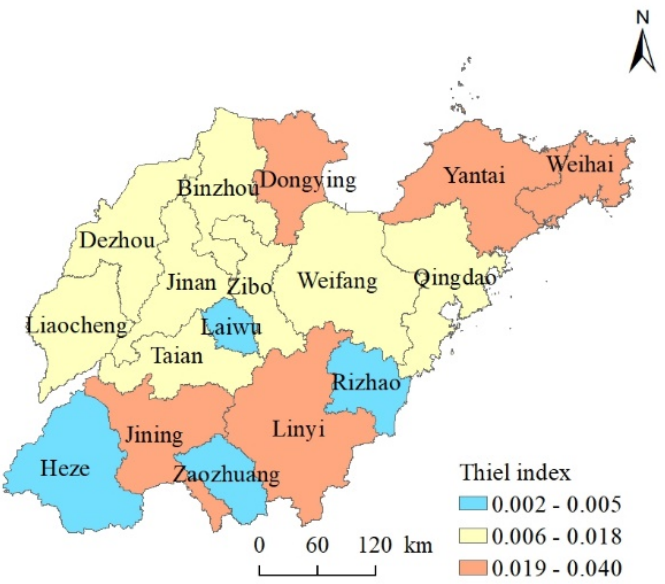
Figure 7. Spatial distribution of the Thiel index in 2018.